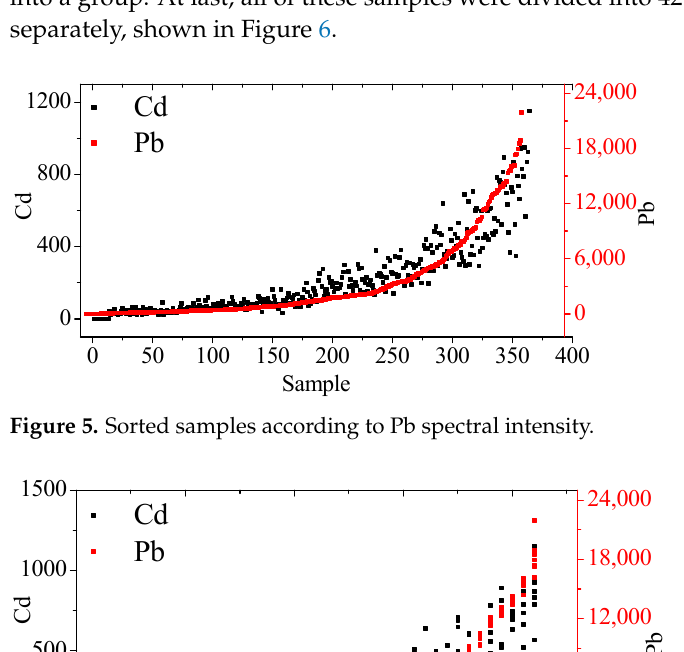
Figure 8. Calibration curve of low content Pb. 4. Conclusions In this study, a calibration method for microdamage quantitative analysis of Pb of laurel leaves by LIBS was successfully established. With the help of this calibration curve, the samples to be tested could be analyzed by LIBS without grinding and pelleting. Alt- hough two elements, i.e., Cd and Pb, were experimented simultaneously, all the samples were sorted according to the spectral intensity of Pb, so the linearity of Cd element was poor. In order to further improve the linear relationship, more samples should be pre- pared and the samples with large single-pulse RSD values can be removed, so that more accurate results can be obtained. This method can better reflect the characteristics of rapid analysis of LIBS. The preliminary results of this experiment indicated that the calibration method could be used in microdamage quantitative analysis of elements in TCM and other naturally grown samples, so as to obtain the distribution information of elements in the sample which might play an important role in plant science. Author Contributions : Conceptualization, N.Z.; Data curation, L.F. and F.C.; Formal analysis, M.M. and G.Y.; Investigation, X.C.; Validation, N.Z.; Writing—original draft, L.F. All authors will be in- formed about each step of manuscript processing including submission, revision, revision reminder, etc. All authors have read and agreed to the published version of the manuscript.